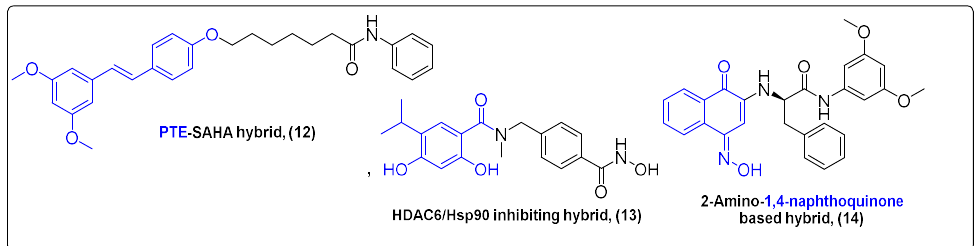
Figure 4. Natural product hybrids bearing phenyl moieties.